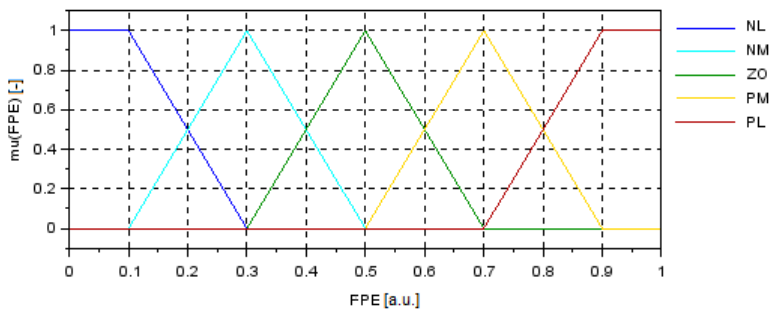
Figure 7. The fuzzy sets defined as: NL, NM, ZO, PM, PL, with specified membership functions of the L -, Λ - or Γ -type.